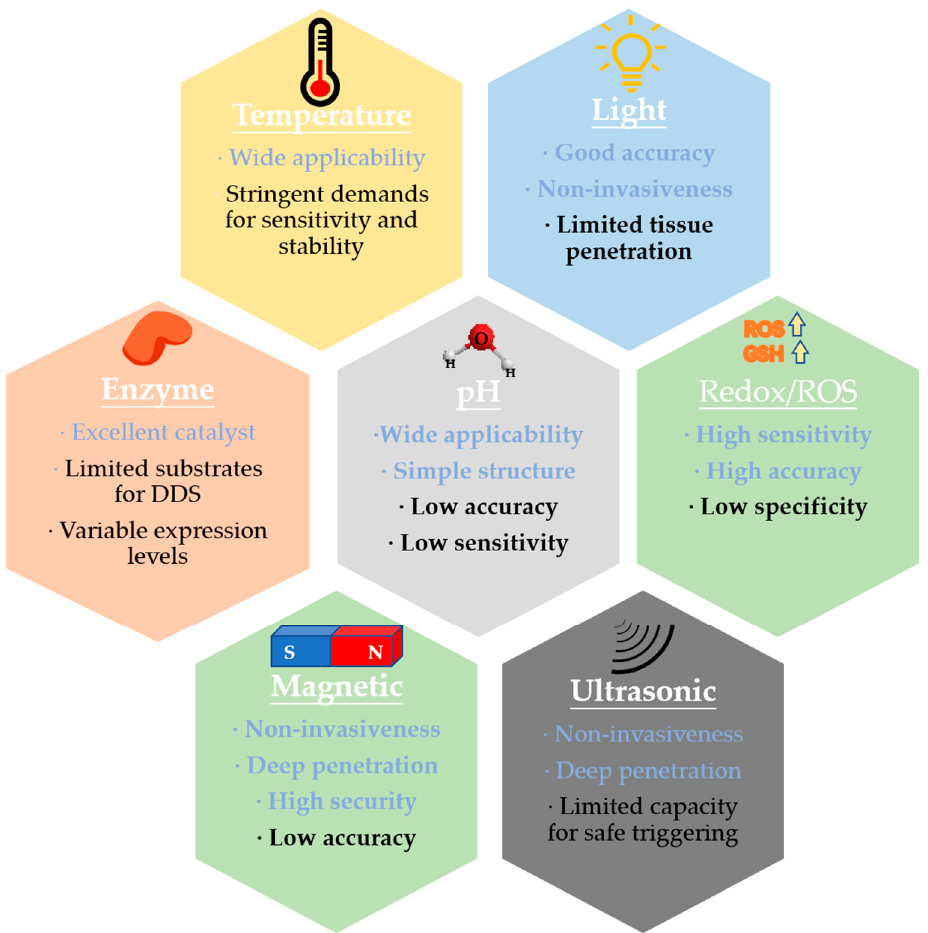
Figure 1. A list of various stimuli used for stimulus-responsive systems, along with advantages and disadvantages.